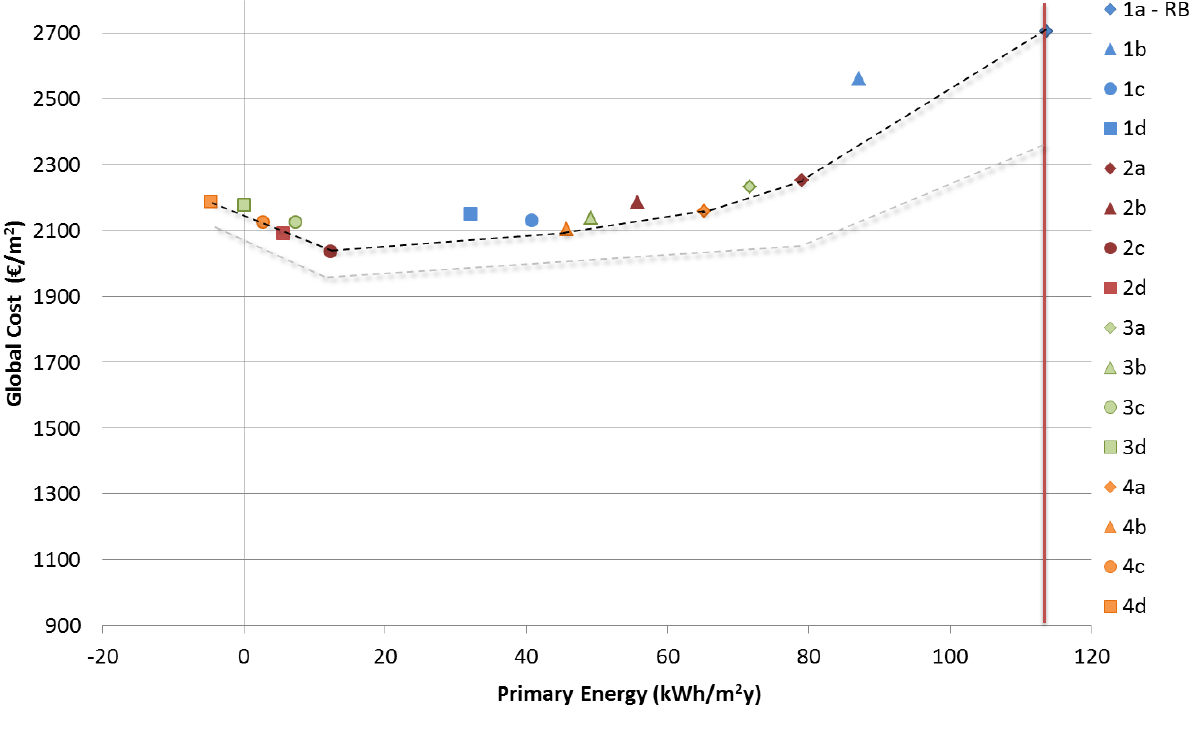
Figure 12. Sensitivity analysis with regard to the escalation of energy